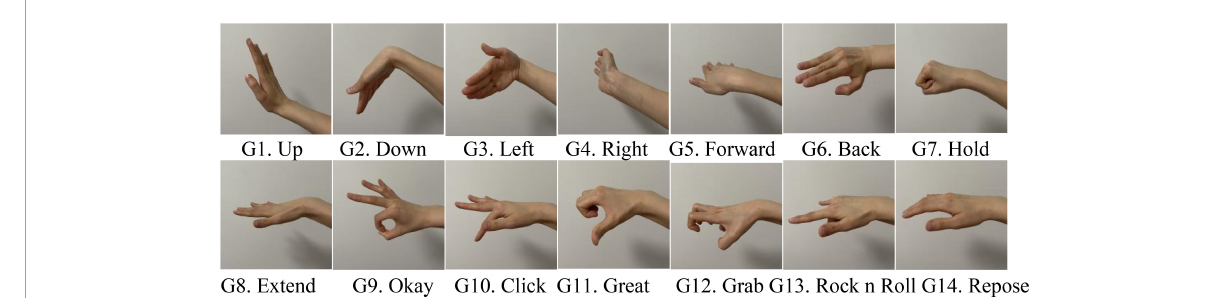
FIGURE1 Fourteen gestures in the target gesture set.